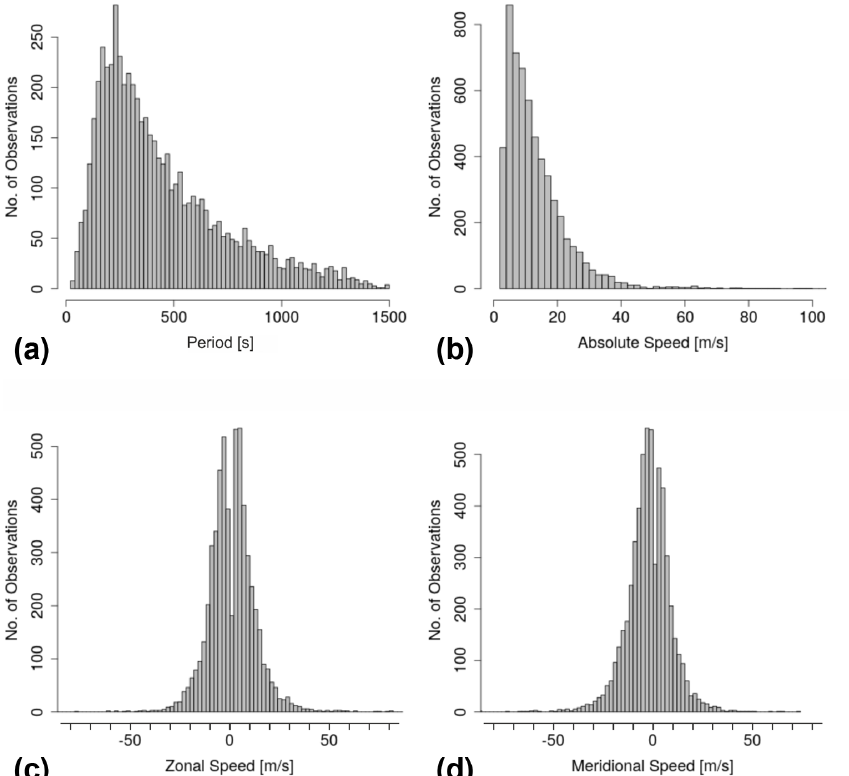
Figure 2. Statistical distribution of observed parameters for wave events with horizontal wavelengths between 48m and 4.5km from 26 Oc- tober 2017 to 6 June 2019 at Otlica, Slovenia. (a) Period; (b) absolute horizontal phase speed; (c) zonal phase speed; (d) meridional phase